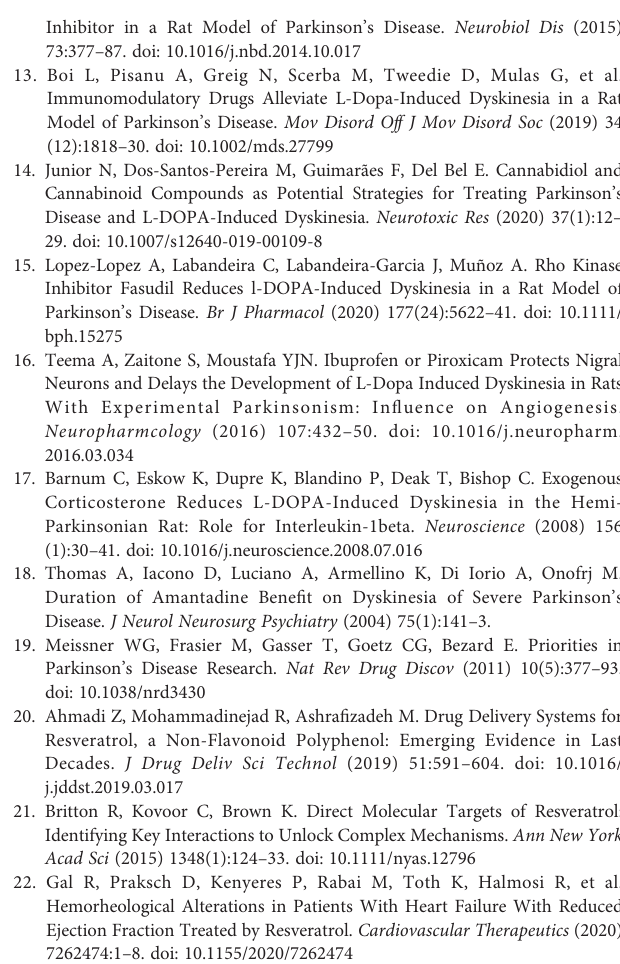
Supplementary Figure 1 | Effects of RES and L-DOPA on DA neuronal survival in the unlesioned side of substantia nigra. After 42 days of L-DOPA treatment, rats were sacri fi ced and brains were collected, respectively. DA neurons in substantia nigra were recognized and immunostained with an anti-TH antibody. DA neuronal survival in the unlesioned side of substantia nigra was analyzed via the quanti fi cationof TH-positive neurons (A) and the expressionof TH protein (B) . Scale bar=100 µm. The densitometry values of TH protein were detected and normalized to GAPDH of the same group. Then, data were normalized and calculated as a percentage of each respective 6-OHDA group. Data were expressed as mean ± SEM from 5